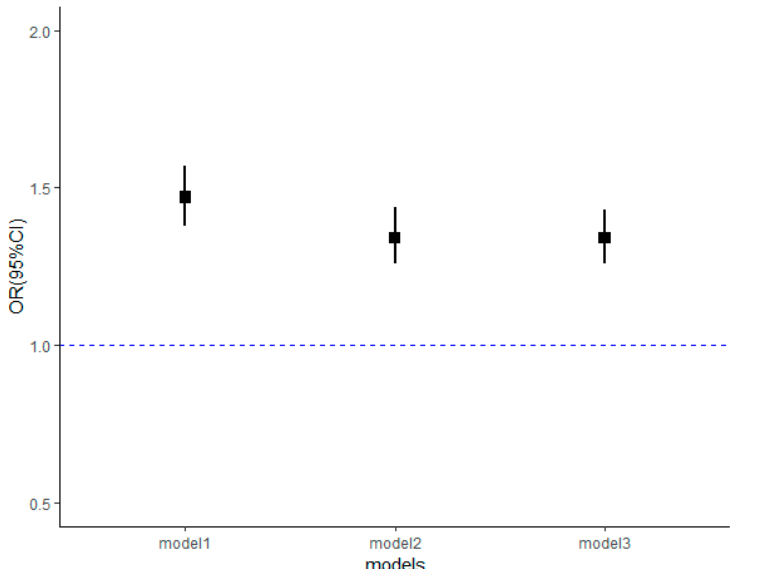
Figure 4. Association between extreme food deprivation and physical (pre)frailty. Table 2. Association of hunger at different age groups with (pre)frailty.